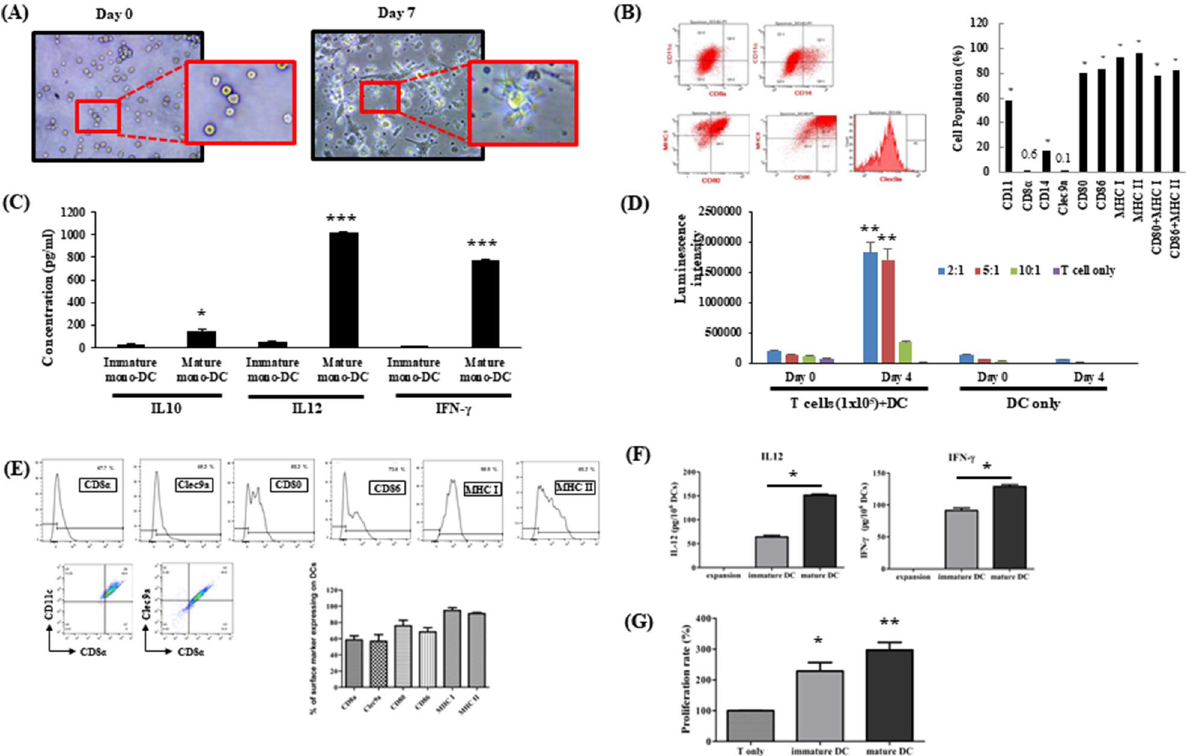
Figure 2. Characterization of mouse myeloid-DC (Mono-DC) and hematopoietic stem-DC (Stem-DC) derived from BM cells pulsed with tumor antigens of ovarian cancer. Mono-DC differentiation is shown from ( A–D ), and stem-DC differentiation is shown from ( E–G ). ( A ) Images of differentiated Mono-DCs at 7 days after BM cell cultures were treated with GM-CSF and IL-4 and pulsed with tumor cell lysates. ( B ) Flow cytometry analysis of differentiated Mono-DCs showing the expression of DC-specific cell surface markers and the absence of CD8α and Clec9a, which are intrinsic characteristics of mouse Stem-DCs. ( C ) Cytokine secretion by differentiated Mono-DCs with or without maturation factors was tested by ELISA at 24 h after stimulation (P = 0.0445, < 0.0001, and 0.0001, respectively). ( D ) T cell proliferation (MLR assay) with different amounts of Mono-DCs (2:1, DC 5 × 10 4 cells + /− T cell 1 × 10 5 cells; 5:1, DC 2 × 10 4 cells + /− T cell 1 × 10 5 cells; 10:1, DC 1 × 10 4 cells + /− T cell 1 × 10 5 cells; T cell only, T cell 1 × 10 5 cells) (P = 0.0030 and P = 0.0044, respectively). ( E ) The typical phenotype of mouse Stem-DC (CD8α, Clec9a) was confirmed by FACS analysis. ( F ) IL-12 and IFN-γ secretion by differentiated stem-DCs with or without maturation factors was tested by ELISA immediately after culture (P = 0.0143 and P = 0.0286, respectively). ( G ) T cell proliferation (MLR assay) with stem-DCs in the presence or absence of maturation factors showed a significant difference compared with T cells only (P = 0.0012). The asterisks represent a statistically significant difference (*, P < 0.05; **, P < 0.01; ***, P < Flow cytometry analysis of differentiated Mono-DCs revealed the expression of DC surface markers, including CD11c, CD80, CD86, MHC I, and MHC II. In addition, no expression of CD8α or Clec9a was observed, which are the intrinsic characteristics of mouse stem-DCs, indicating CTLs and myeloid lineage cells, respectively (Fig. 2B). Furthermore, immunostimulatory cytokines, such as IL-12 and IFN-γ, were secreted from mature Mono-DCs, and T cell proliferation was confirmed in proportion to the number of Mono-DCs (Fig. 2C,D). In contrast to Mono-DCs, the typical phenotype of mouse Stem-DCs induced by SCF and Flt3L was clearly con- firmed as CD8α+ Clec9a+ cells (Fig. 2E). Similar to Mono-DCs, we identified not only the secretion of IL-12 and IFN-γ but also T cell proliferation induced by mature Stem-DCs (Fig. 2F,G). DC treatments affect tumor growth and ascites formation. We harvested all mice treated with Stem-DCs, Mono-DCs, and the vehicle control between 7 and 8 weeks after the intraperitoneal injection of 5 × 10 6 ID8 cells, although some mice in the vehicle control died earlier than we expected before the last DC injection because of tumor progression (Fig. 3). Most mice appeared to form ascites from 4 weeks after ID8 cell injection, which was confirmed by increasing abdominal circumferences. We observed significantly smaller body weights in the high- and medium-dose pulsed Stem-DC groups than in the vehicle group (P = 0.0323 and P = 0.0183, respectively). There were no differences in body weights according to the type of DC treatment among the DC-treated groups. When we compared the volume of ascitic fluid carefully collected at harvesting, all of the DC-treated mice showed a reduced volume of ascites.